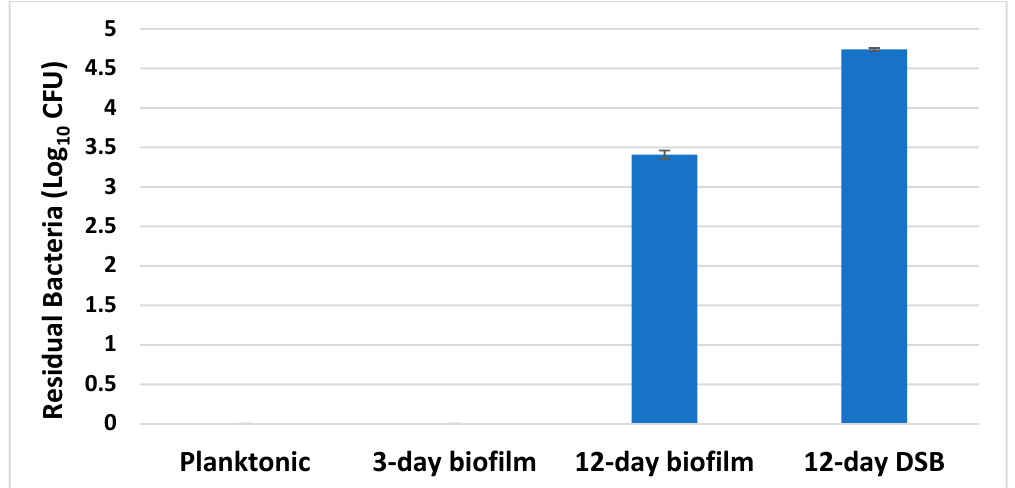
Figure 6. The concentration of available chlorine (column graph) necessary to kill 10 7 S. aureus planktonic, hydrated 3-day, and 12-day biofilm, and dry surface biofilm cells (DSB) and corresponding cell wall thicknesses (mean ± std) (orange dot and bar).